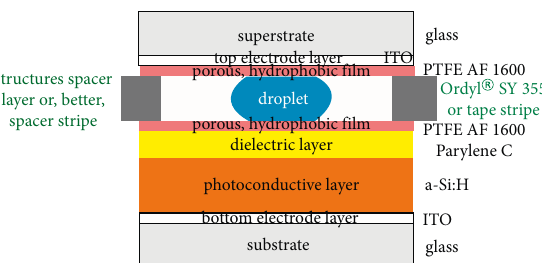
Figure 2: Cross-sectional view (not to scale) of layer sequence of DMF chip. Typical materials and layer thicknesses from bottom to top: 1.0mm thick glass slide (substrate), (100 ± 30) nm thick ITO electrode layer, (780 ± 10) nm thick a-Si :H photoconductive layer, (360 ± 10) nm thick Parylene C dielectric layer, approx. 10 nm thin hydrophobic PTFE AF 1600 film, from 50 μ m up to 250 μ m thick spacer stripe or 100 μ m thick insulating tape, approx. 10nm thick hydrophobic PTFE AF 1600 film again, (100 ± 30) nm thick ITO electrode layer, and 1.0mm thick glass slide (superstrate).